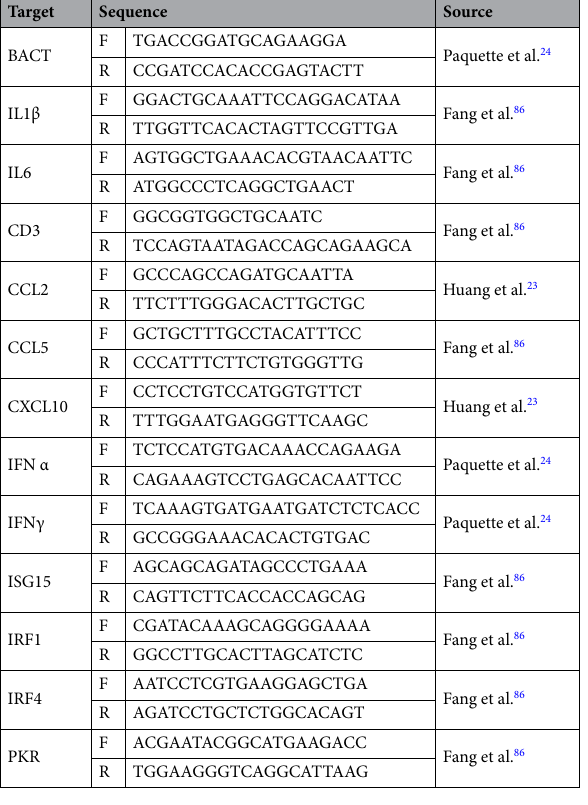
Table 1. qPCR primer